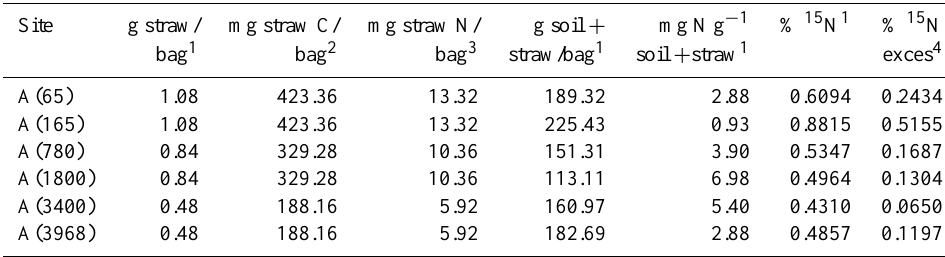
Table 2. Composition of soil in bags buried in 5–10cm soil